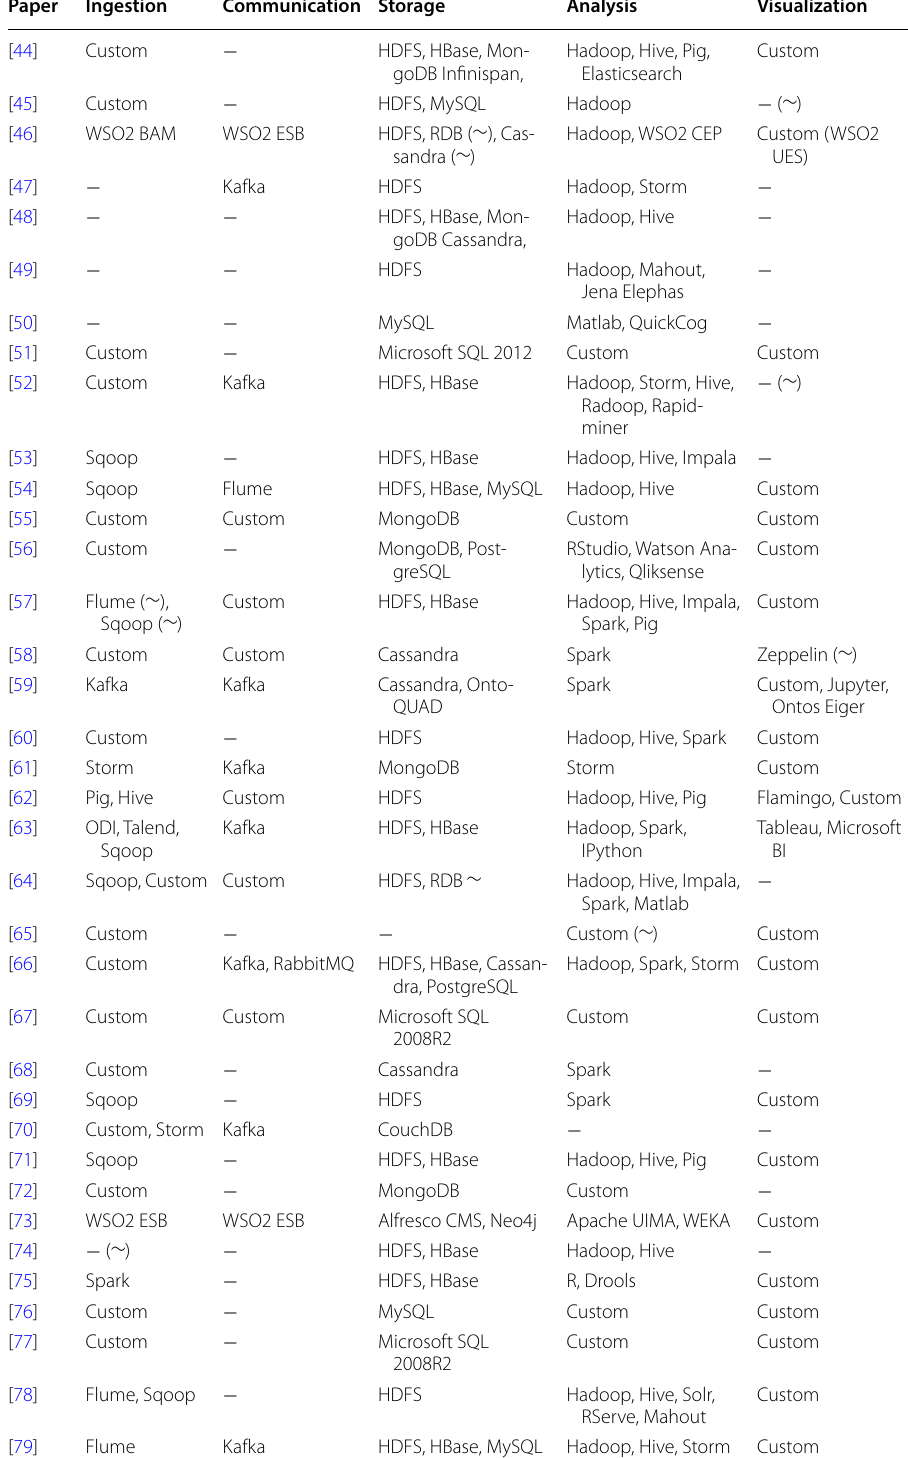
Table 4 The tools used in the respective data analysis pipelines of each paper